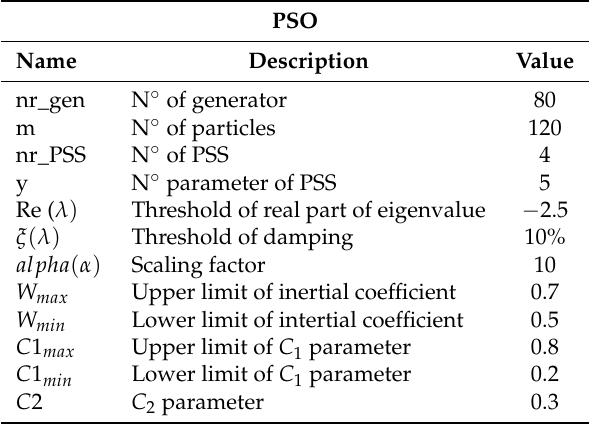
Table 5. Variables of PSS for system III.